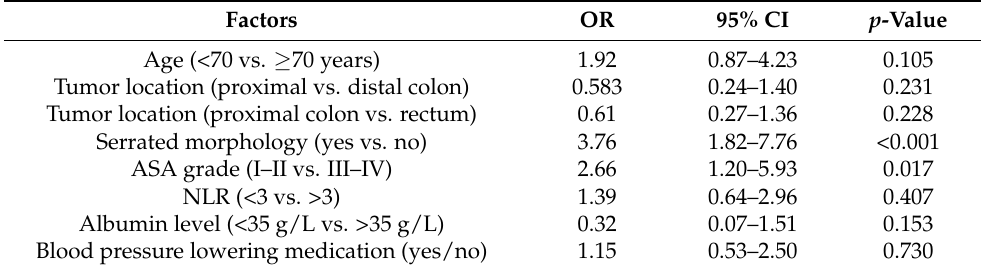
Table 4. Multivariable binary regression model for myosteatosis probability.